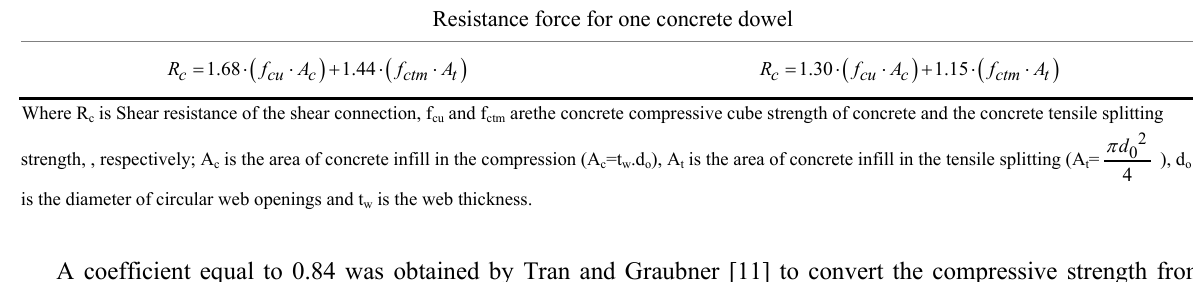
Table 1: Analytical procedures for shear longitudinal resistance Huo and D’Mello [9] Chen et al. [10] Resistance force for one concrete dowel